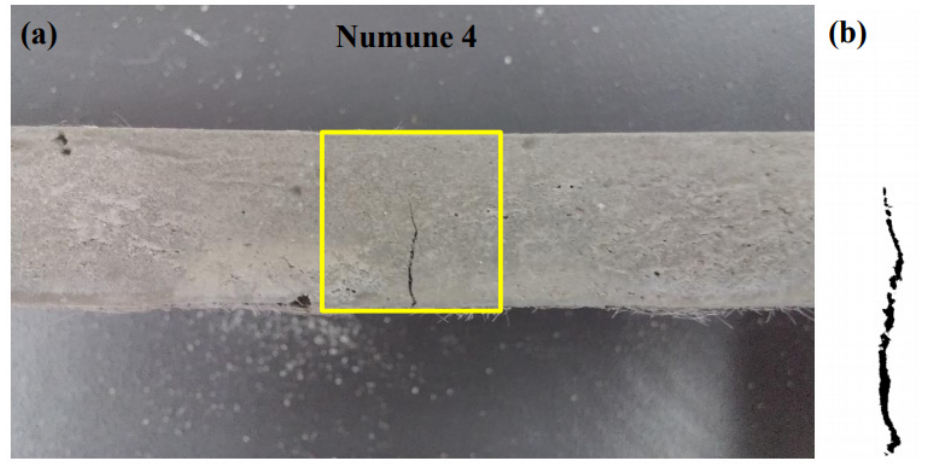
Figure 12. ( a ) An example of the crack on the studied sample ( b ) the extracted map of the